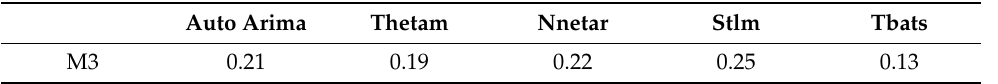
Table 10. The M3 model’s component weights for “psychiatrist” score forecasting.